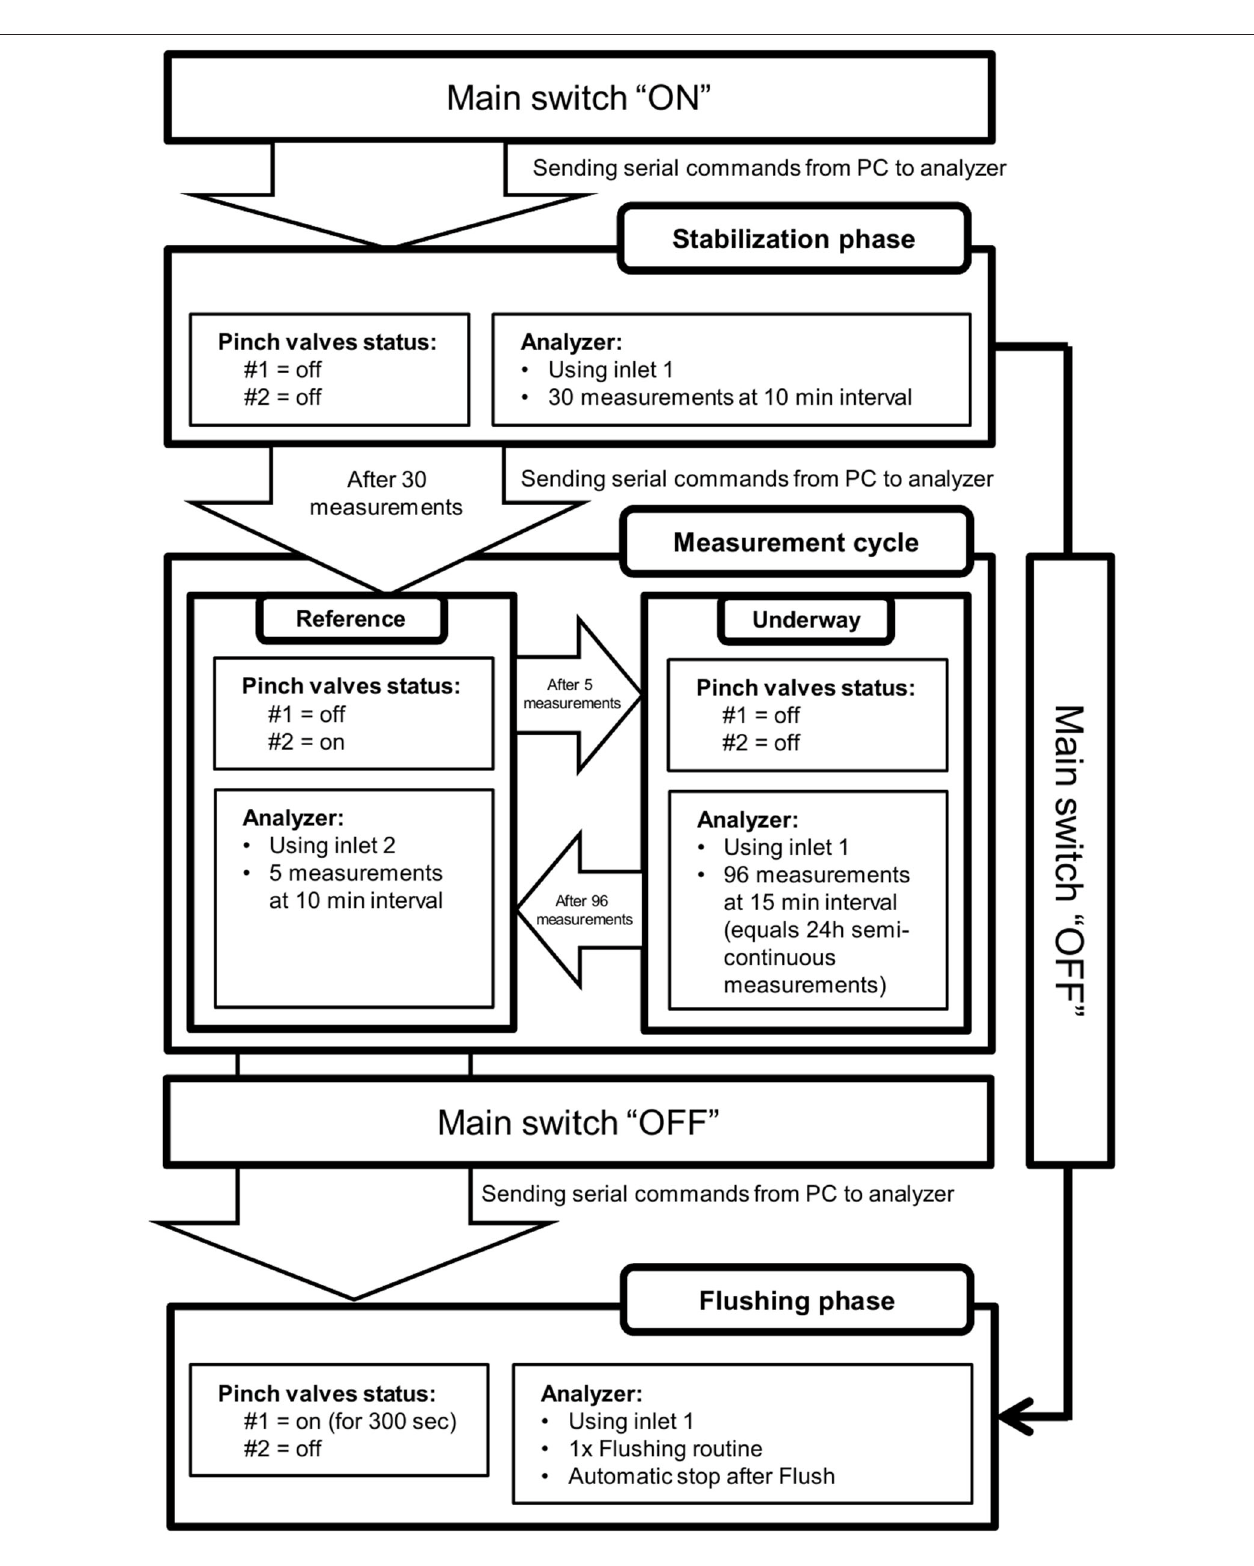
FIGURE 4 | Workflow of the autonomous TA measurements.